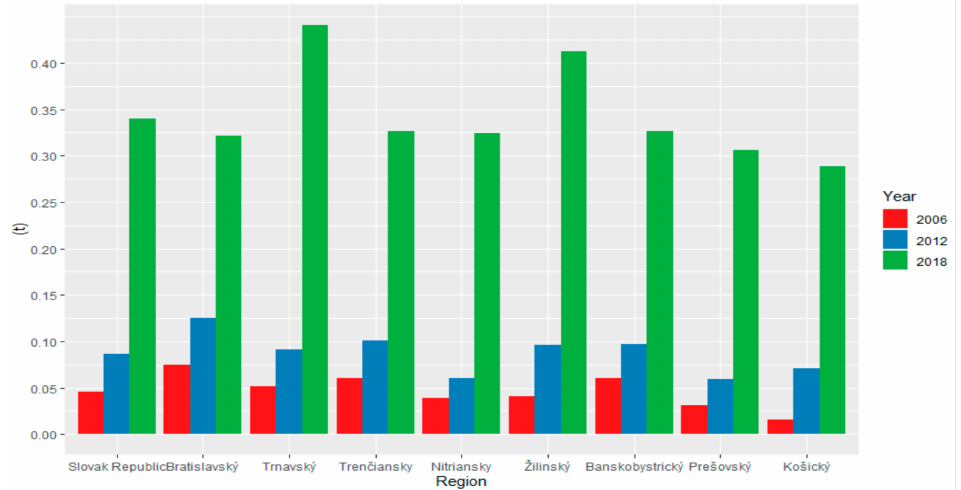
Figure 3. Productivity of separated waste.